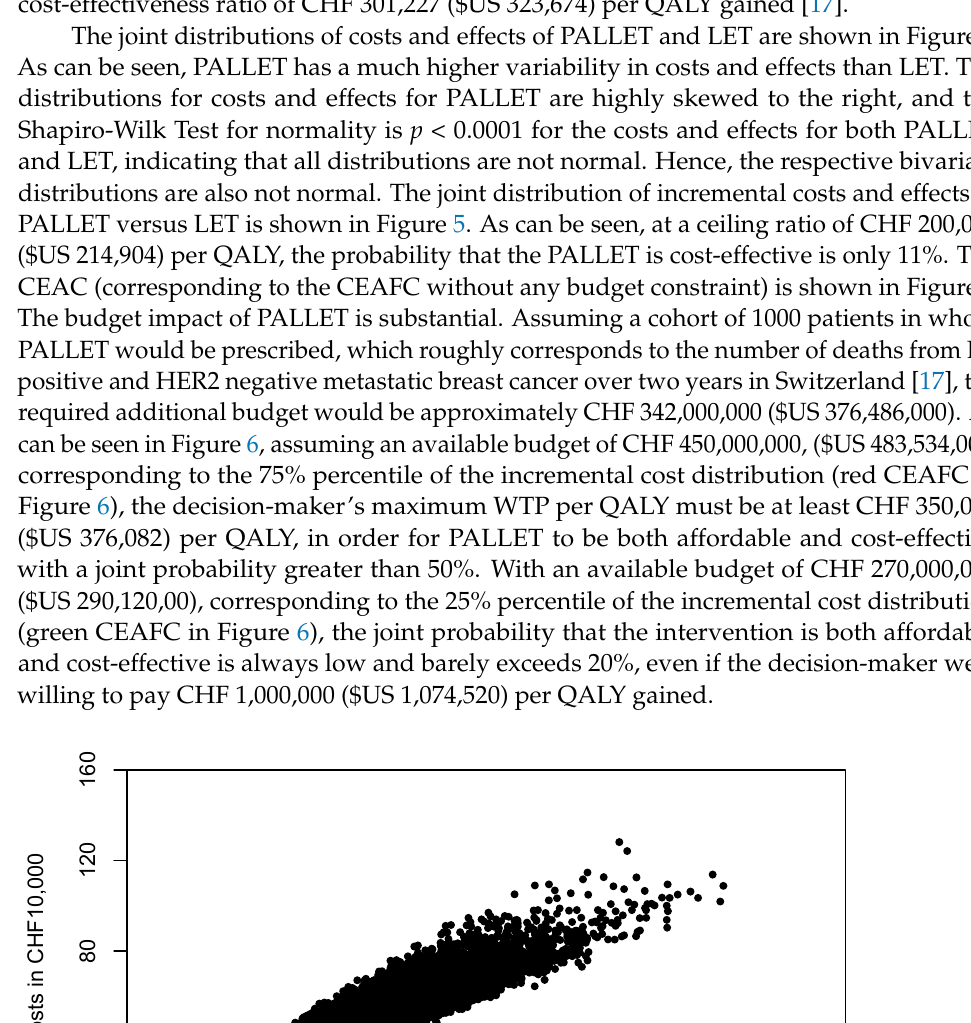
Figure 5. Incremental costs and effects of PALLET (palbociclib and letrozole) versus LET (letrozole) in patients with metastatic ER + HER2- breast cancer. The red line represents the ceiling ratio. The proportion of samples below the ceiling ratio represents the probability that PALLET is cost-effec- tive at CHF 200,000 per QALY, which is 11%. One CHF (Swiss Franc) corresponds to $US 1.07.